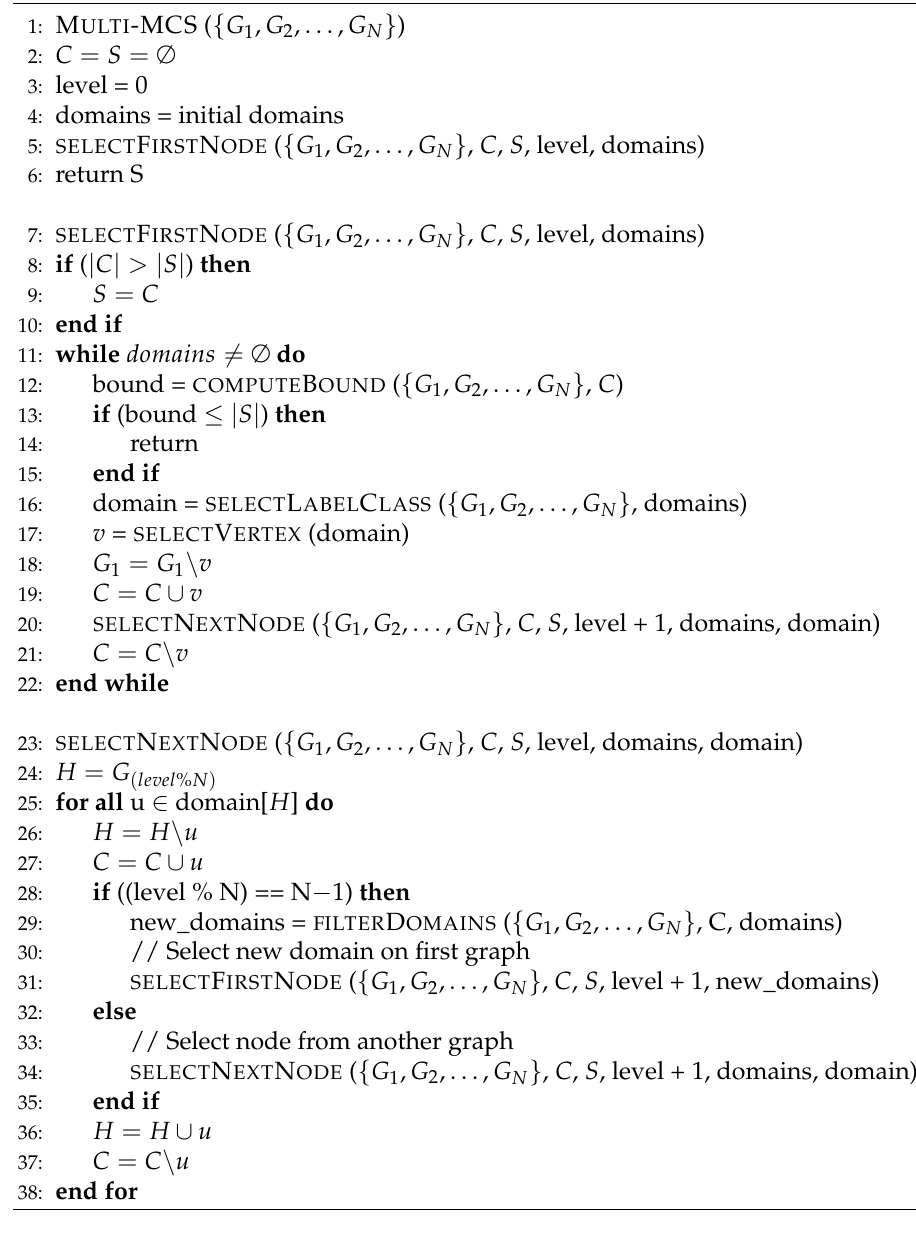
Algorithm 1 The sequential Multi-MCS function: A unique recursive branch-and-bound procedure that given N graphs { G 1 , G 2 , . . . , G N } and computes MCS { G 1 , G 2 , . . . , G N